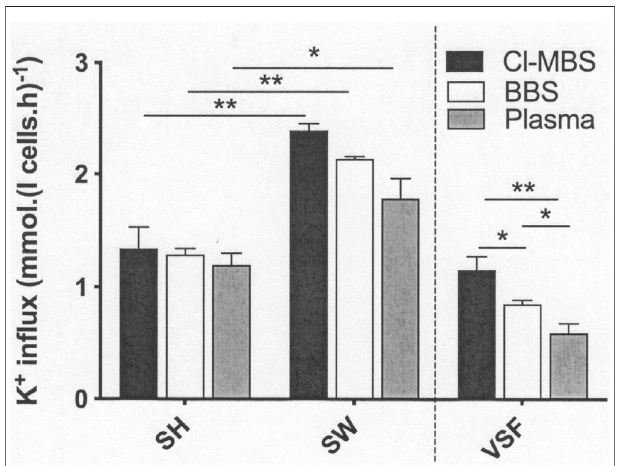
FIGURE 1 | The effect of incubation media on volume-sensitive KCl cotransport activity in LK sheep red cells. Red cells (50% Hct) from LK sheep were equilibrated in Eschweiler tonometers for 15 min at an O 2 tension of 100 mmHg under isotonic conditions (osmolality 290 mOsm.kg − 1 ). Extracellular pH was pH 7.4, adjusted using HNO 3 /NaOH in MOPS-buffered saline (MBS), or with CO 2 (43 mmHg) in the case of bicarbonate-buffered saline (BBS) and plasma. Red cell aliquots were then diluted ten-fold into test tubes pre-equilibrated with the same gas mixtures to alter cell volume anisotonically and for measurement of K + in fl ux (extracellular [K + ] of 7.5 mM) over 10 min. Cell volume was altered through addition of hypertonic sucrose (15% shrunken; SH) or water (15% swollen; SW). All K + in fl uxes were carried out in the presence of ouabain (100 µM) and bumetanide (10 µM) to inhibit K + in fl ux through the Na + /K + pump and Na + -K + -Cl - cotransporter (NKCC), respectively. The volume-sensitive component of the K + fl ux (VSF) represents the changes induced by altered (at ± 15% osmolality cf isotonic conditions). Histograms represent means ± S.E.M., n = 4. p p ≤ 0.05; pp p ≤ 0.01.